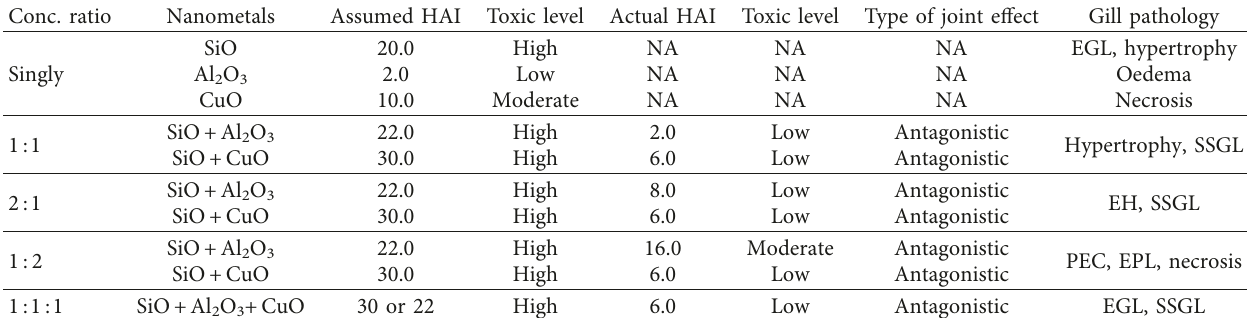
Table 2: A 28-day single and joint exposure of Clarias gariepinus to nanosize metals. Conc. ratio